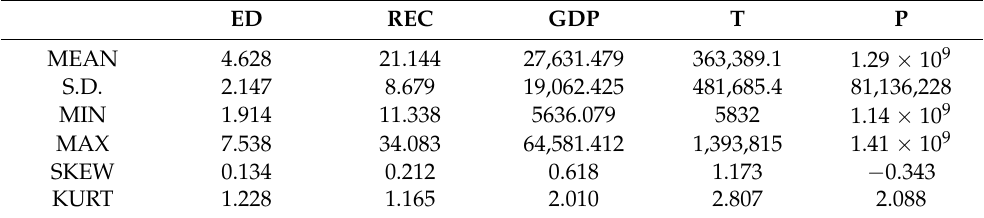
Table 1. Descriptive Statistics.